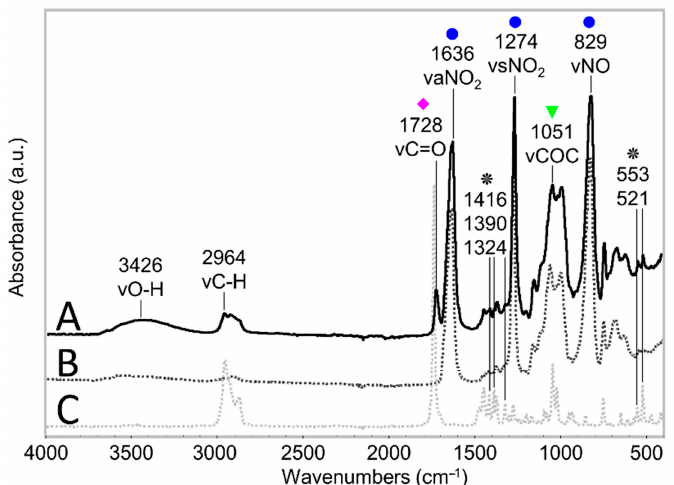
Figure 7. ATR-FTIR spectra of an unaged celluloid sheet (A), of pure CN (B) and camphor (C) references. The COC stretching reference band is highlighted with a green triangle, probe bands related to the NO 2 group are marked with a blue circle, and the C=O stretching band is highlighted with a magenta diamond. Bands representative of camphor presence are marked with a black star. Each spectrum has been normalized considering the strongest infrared band.